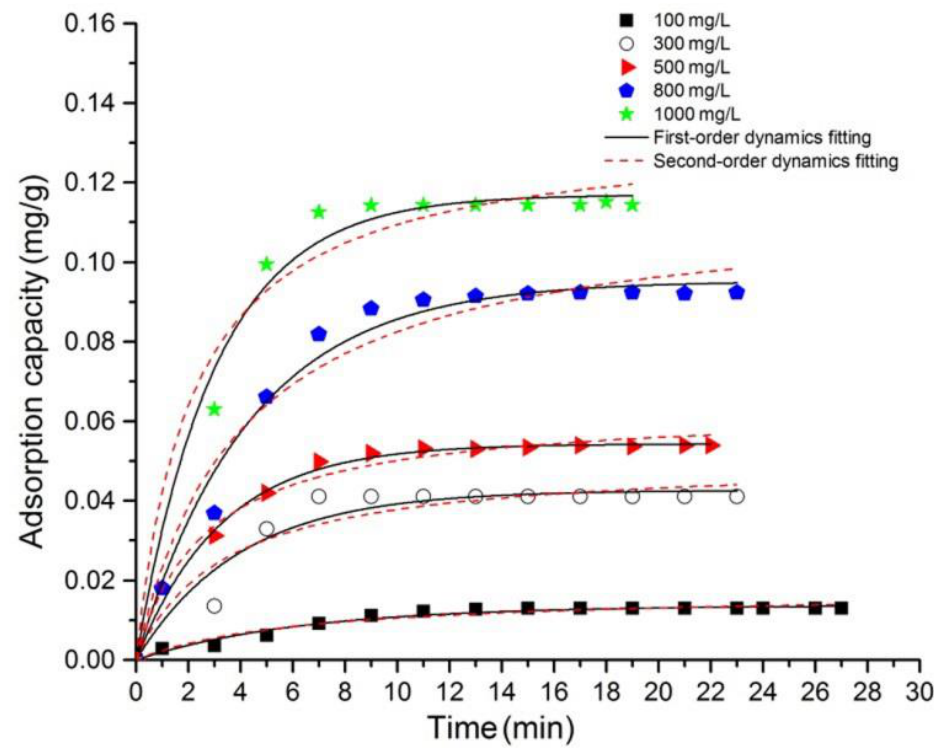
Figure 7. The curve of the electrosorption capacity with time under different concentrations.